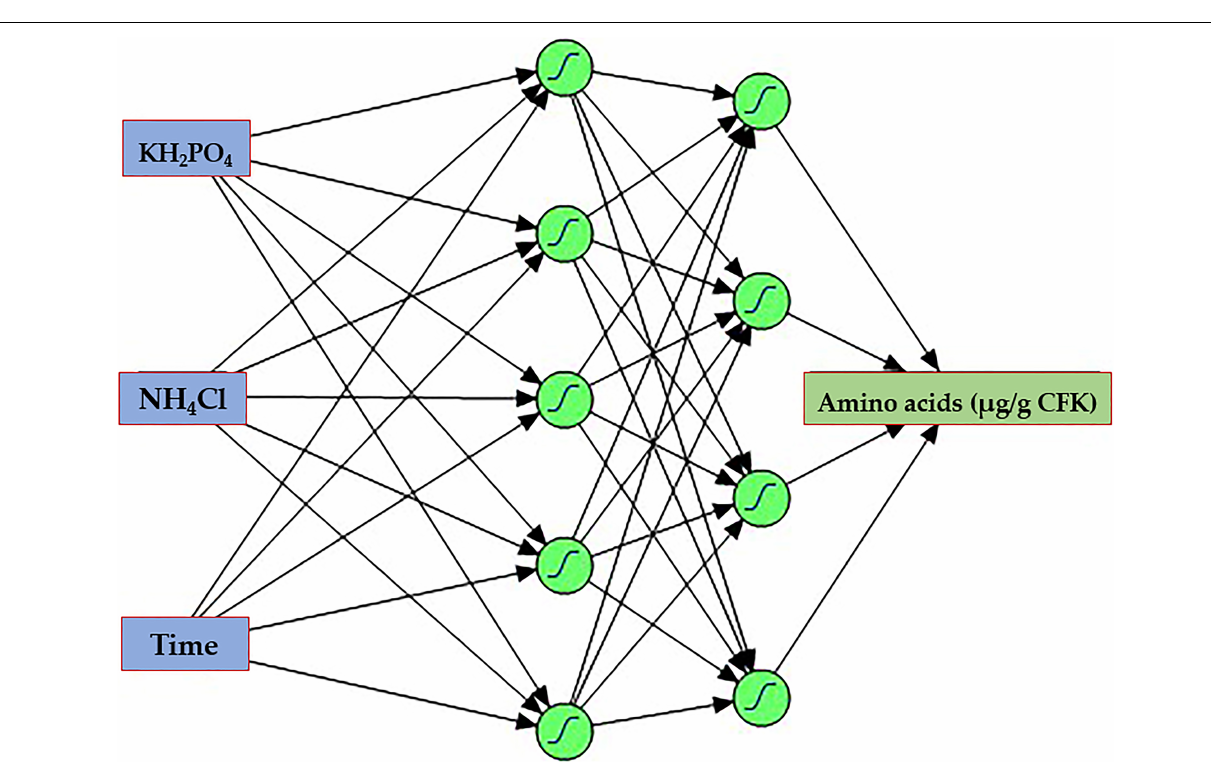
FIGURE 8 | The architecture scheme of the artificial neural network, NTanH(4)NTanH(5), containing one input layer (three neurons), two hidden layers (four and five neurons), and an output layer (one